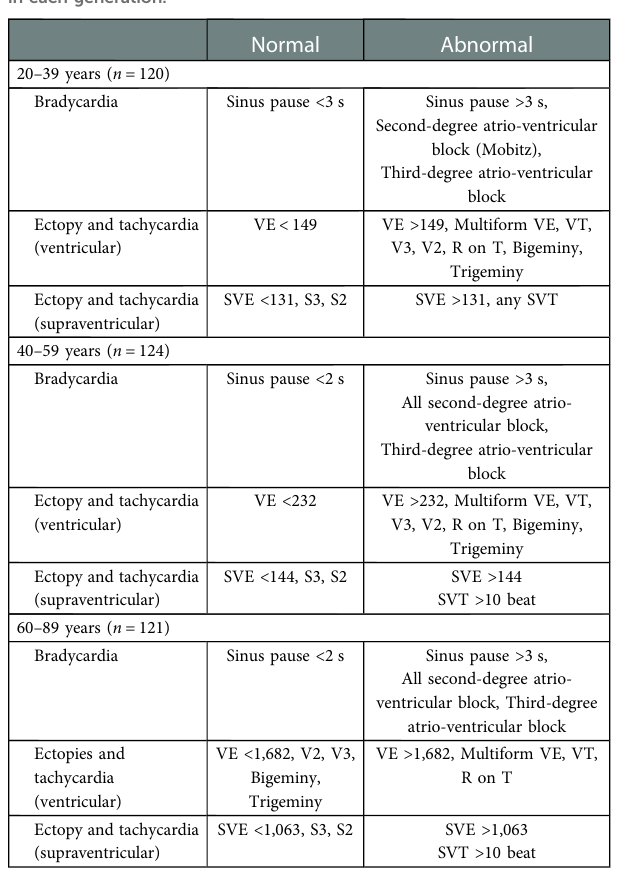
TABLE 7 Differentiation between the normal and abnormal AECG fi ndings in each